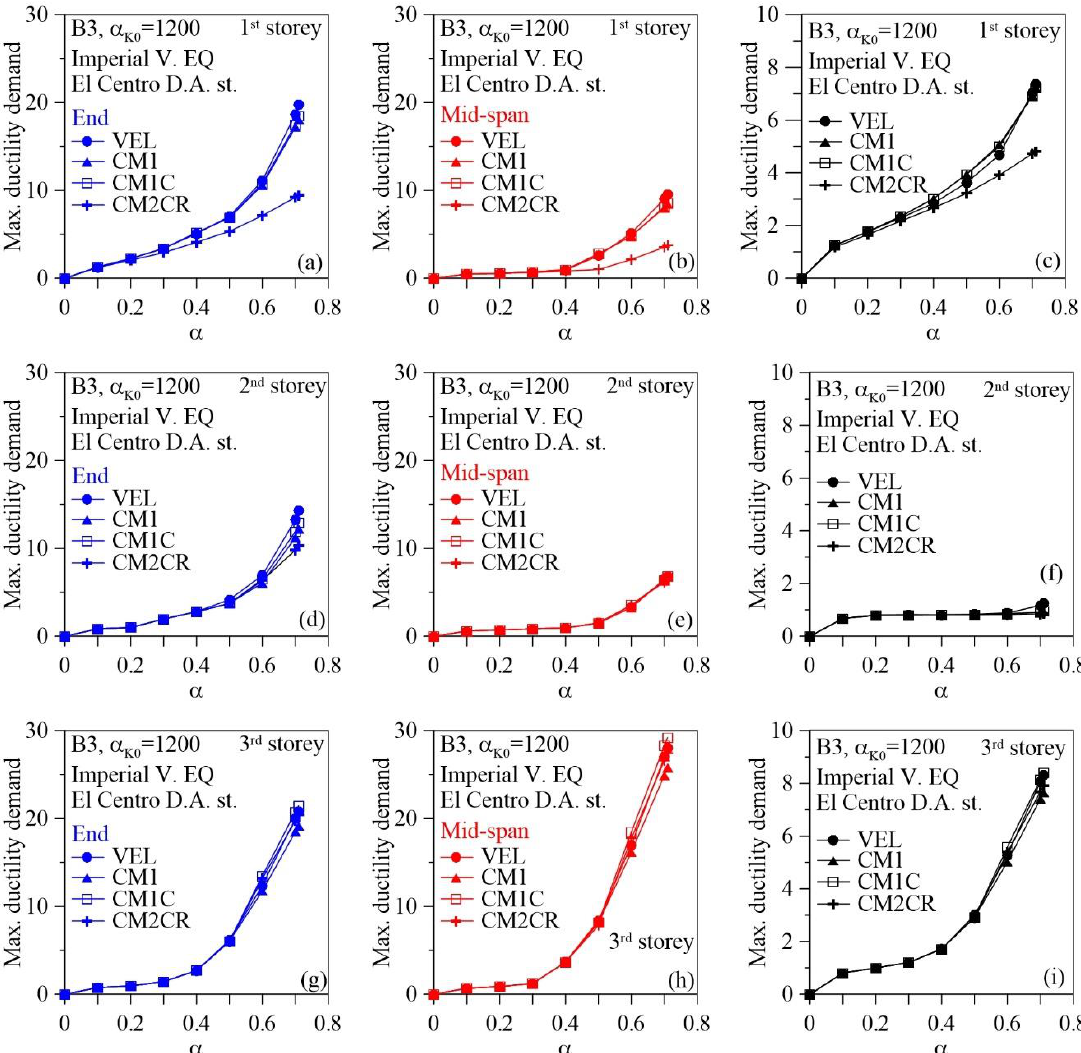
Figure 4. Ductility demands of the B3 structure subjected to the Imperial Valley EQ: end sections ( a , d , g ) and mid-span sections ( b , e , h ) of beams; end sections ( c , f , i ) of columns.